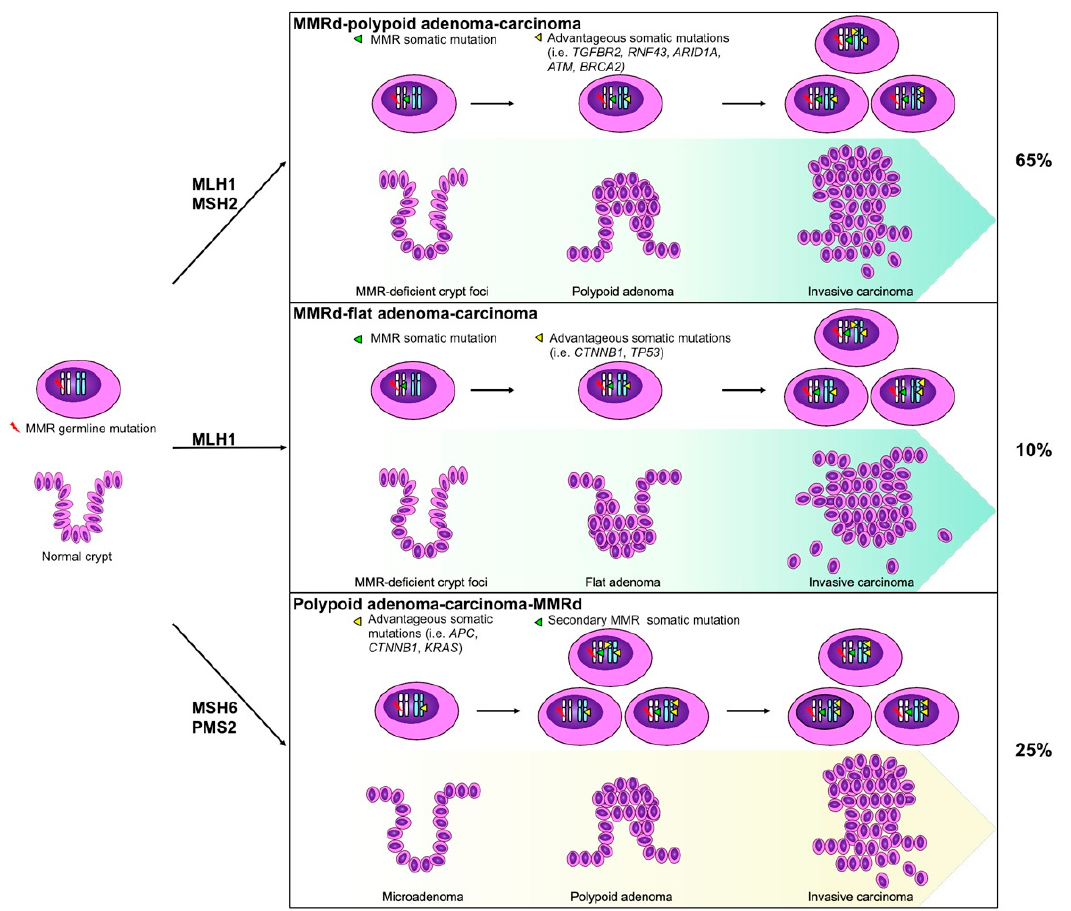
Figure 2. The three-pathways carcinogenic model in LS. A cartoon represents the hypothetical mechanisms of cancer development in LS with parallel intranuclear genetic events (above) and morphologic lesion in the colorectum (below). The somatic cell harboring a heterozygous germline mismatch repair (MMR) gene mutation is MMR-proficient and thus microsatellite stable (MSS). In the two upper models, the cells first acquire a somatic mutation in the same MMR gene, giving rise to MMRd crypt foci, morphologically normal, or only slightly altered, but with loss of MMR immunohistochemical staining. Then, depending on the further acquired mutation, they can progress to a polypoid lesion (with TGFBR2 , RNF43 , ARID1A , ATM, or BRCA mutation) or a flat lesion (in case of CTNNB1 or TP53 mutation), and thus becomes invasive. The third model is analogous to the sporadic microsatellite stable process, and MMRd can occur as a late